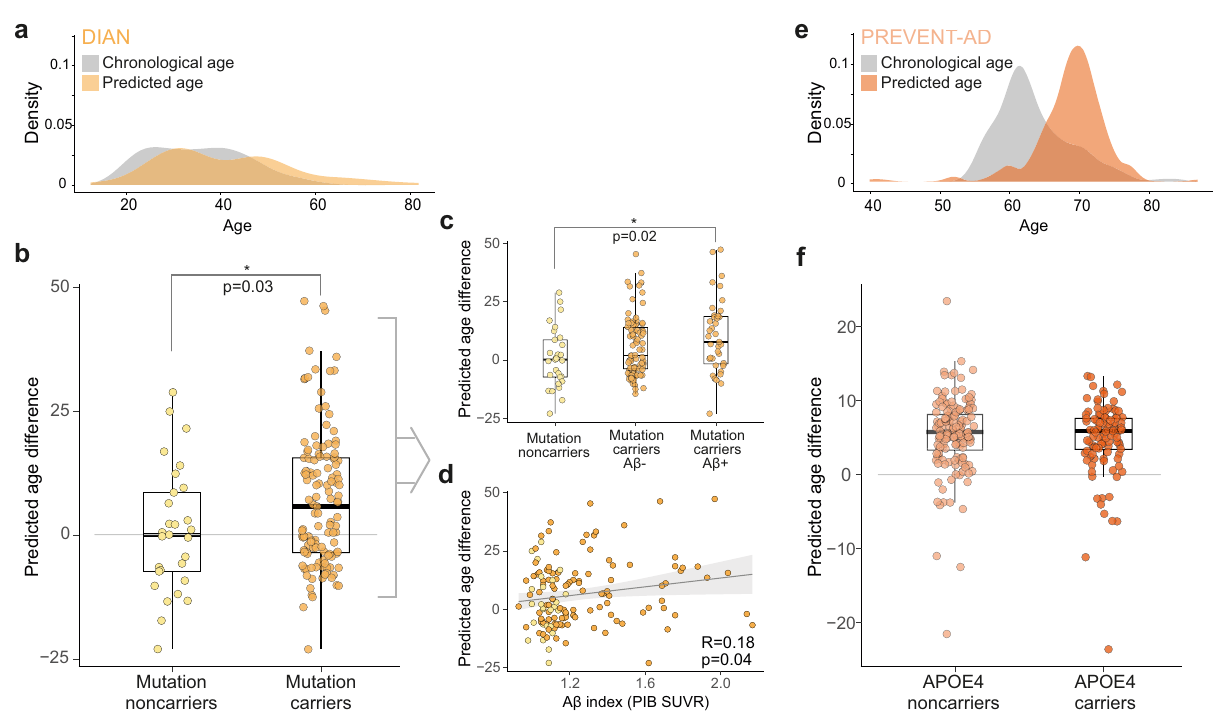
Fig. 3 Predicted age difference in DIAN and PREVENT-AD. Density plot of chronological age vs predicted age in the test set participants in DIAN ( n = 154) ( a ). Brain age is overestimated in autosomal dominant mutation carriers ( n = 125) compared to non-carriers ( n = 29) ( b ). The overestimation in mutation carriers is in part due to A β , with a difference between mutation noncarriers ( n = 29) and A β + mutation carriers ( n = 39) only (A β − mutation carriers [ n = 75] did not differ from the other groups) ( c ), and an association between A β load and predicted age difference across the whole cohort ( n = 154) ( d ). Light (yellow) colors represent DIAN mutation non-carriers and darker (orange) colors represent DIAN mutation carriers. Density plot of chronological age vs predicted age in the test set participants in PREVENT-AD ( n = 256) ( e ). In individuals at risk of sporadic Alzheimer ’ s disease, brain age is overestimated irrespectively of APOE ε 4 genotype ( f ). Light (salmon) colors represent PREVENT-AD APOE ε 4 non-carriers ( n = 147) and darker (dark orange) colors represent PREVENT-AD APOE ε 4 carriers ( n = 108). For b , c and f the interquartile range (25th Percentile, Median and 75th Percentile), the whiskers (lines indicating variability outside the upper and lower quartiles minimum value) and the individual dots are presented. For d , shaded (gray) area represents con fi dence intervals (95%). Statistical values were obtained from general linear models ( b , c , f ) or partial Pearson ’ s correlations ( d ), controlling for chronological age, without further adjustment (two-sided tests). A β : beta-amyloid, A β − : amyloid-negative, A β + : amyloid- positive; APOE4 : apolipoprotein E4, PIB: Pittsburgh compound B, SUVR: standardized uptake value ratio. Source data are provided as a Source data fi age for each dataset in Fig. 2c. As expected, predicted age was correlated with chronological age in the training set ( R 2 = 0.53, p < 0.0001; rmse = 14.01, mean absolute error [mae] = 11.00; Fig. 2c left) and the validation set ( R 2 = 0.49, p < 0.0001; rmse = 13.84; mae = 11.90; Fig. 2c middle). Of note, the neural